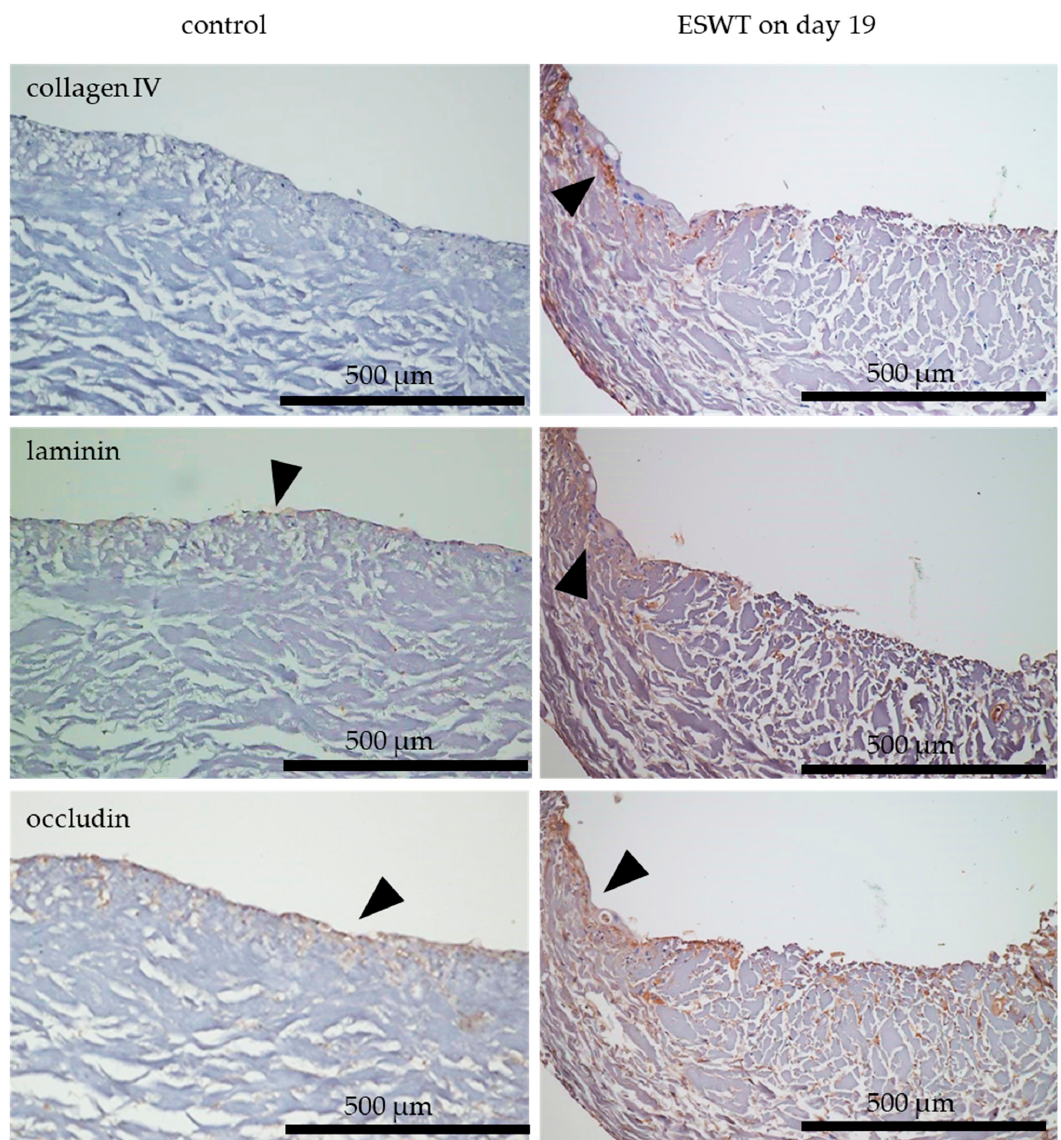
Figure 7. Formation of a basement membrane in oral mucosa equivalents (tri-culture) on culture